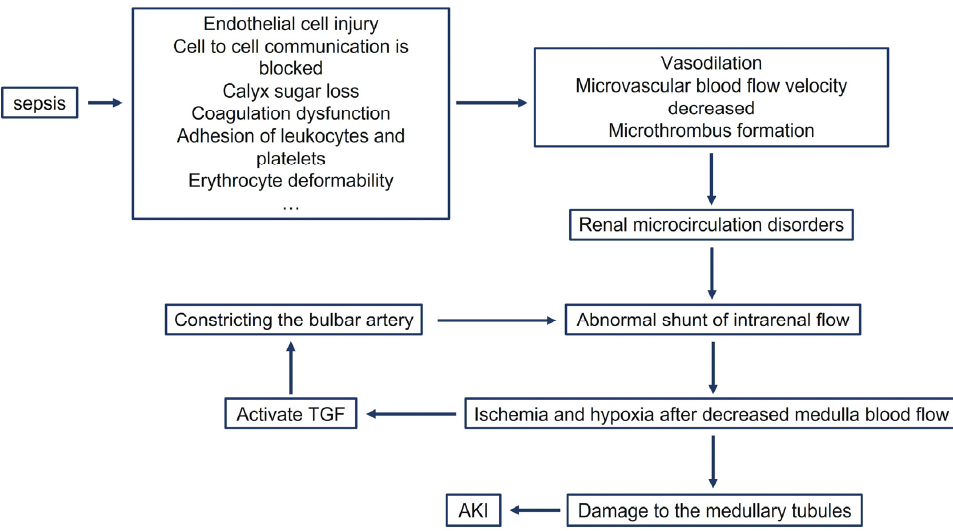
Figure 1. Pathophysiological mechanism of microcirculatory dysfunction affecting renal function in sepsis. TGF, tubuloglomerular feedback mechanism.